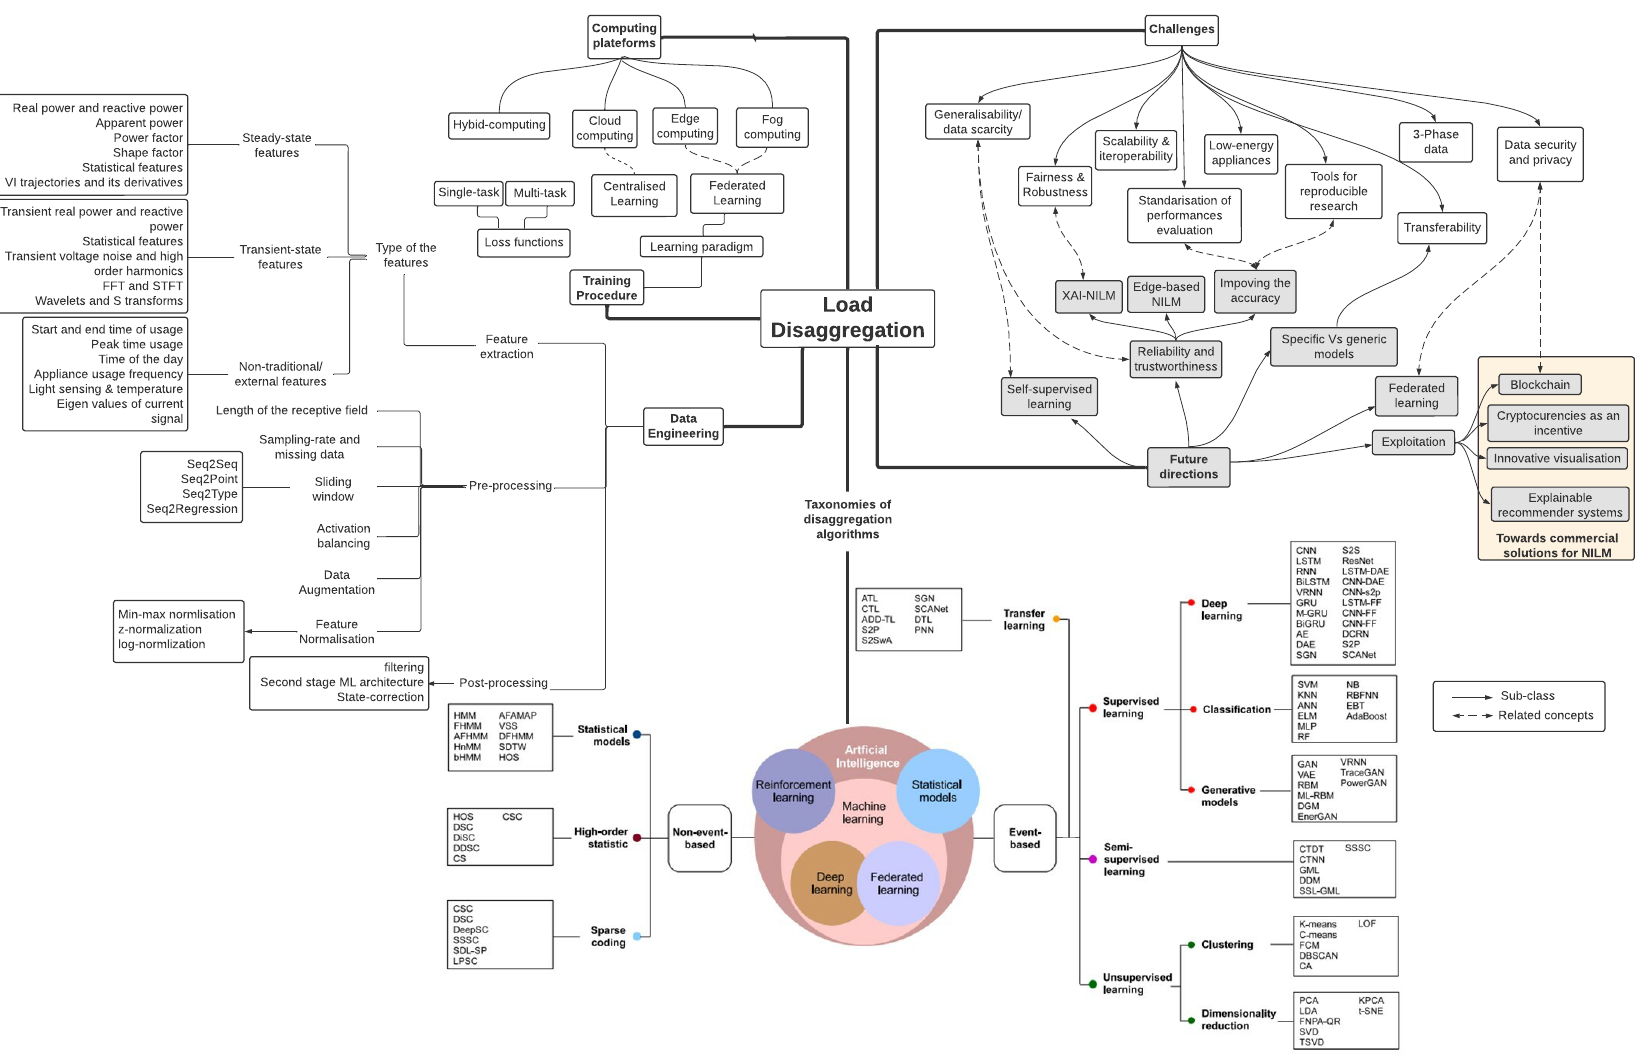
Figure 2. Overview of NILM concepts included in the reviewed reviews (extended from